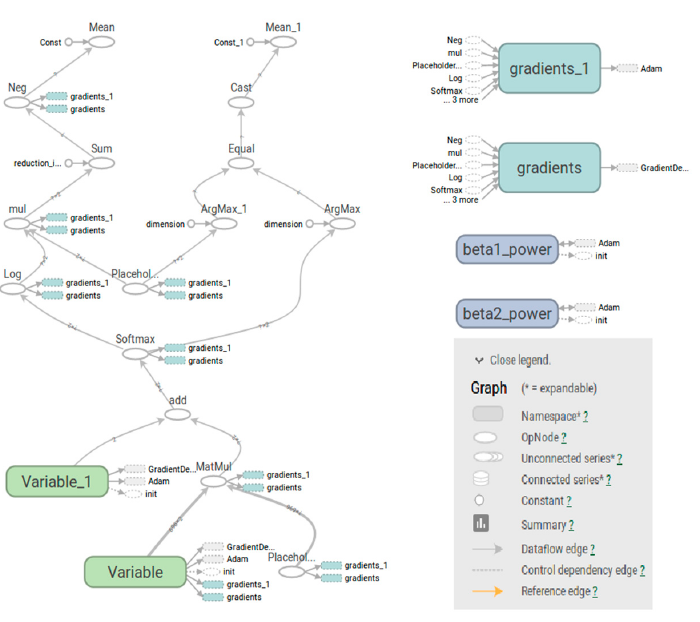
Figure 6. Structure using G-Descent.